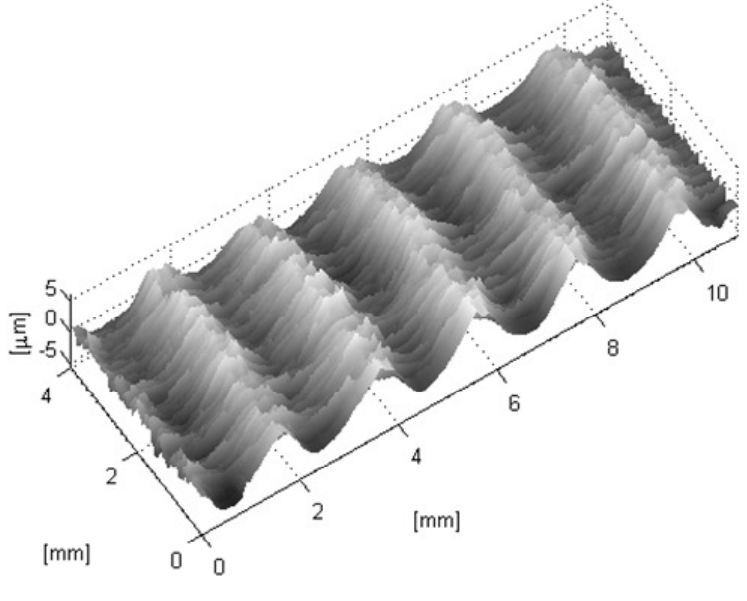
Figure 6. 3D surface reconstruction of a Rubert Type 130 reference specimen of a surface machined by horizontal milling (in this case the N7), where the marks of the machining process are clearly